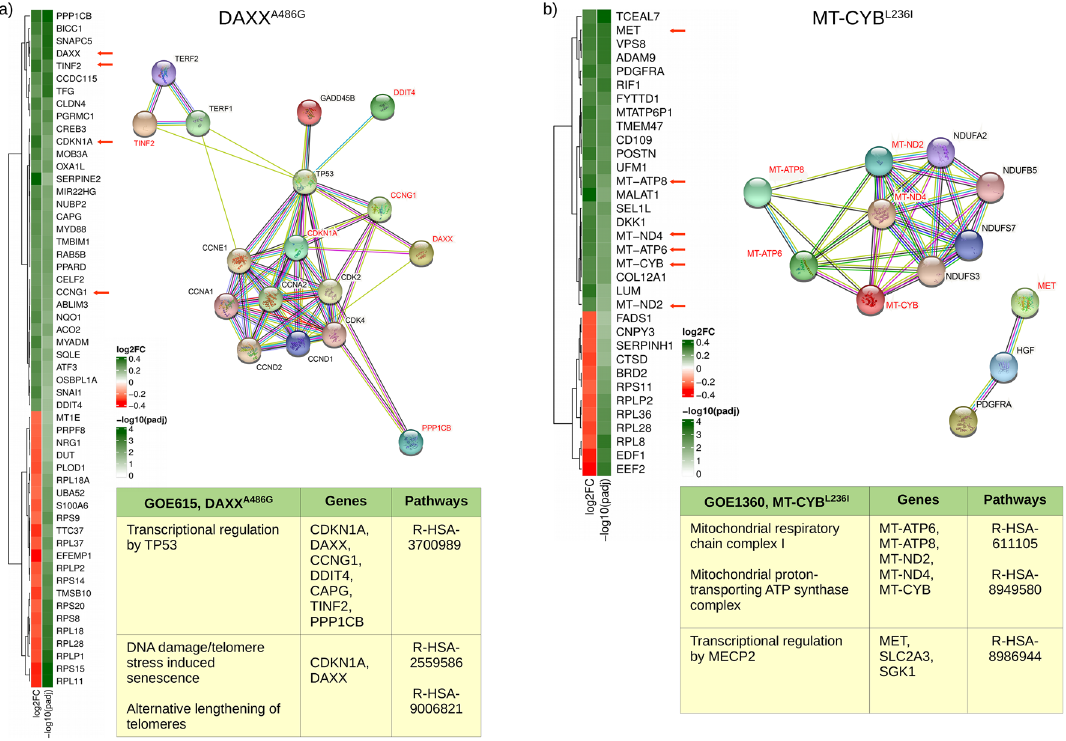
Figure 6. Variant-associated expression signatures in GOE615 and GOE1360. ( a ) Heatmaps showing log2FC and- log10 of adjusted p value for genes differentially expressed in mutant vs nonmutant cells for DAXX A486G variant in sample GOE615 related to protein–protein interaction showing phenotype (StringDB) and pathways (Reactome) for this specific variant. ( b ) Heatmaps showing log2FC and- log10 of adjusted p value for genes differentially expressed in mutant vs non-mutant cells for MT-CYB L236I variant in sample GOE1360 related to protein–protein interaction showing phenotype (StringDB) and pathways (Reactome) for this specific